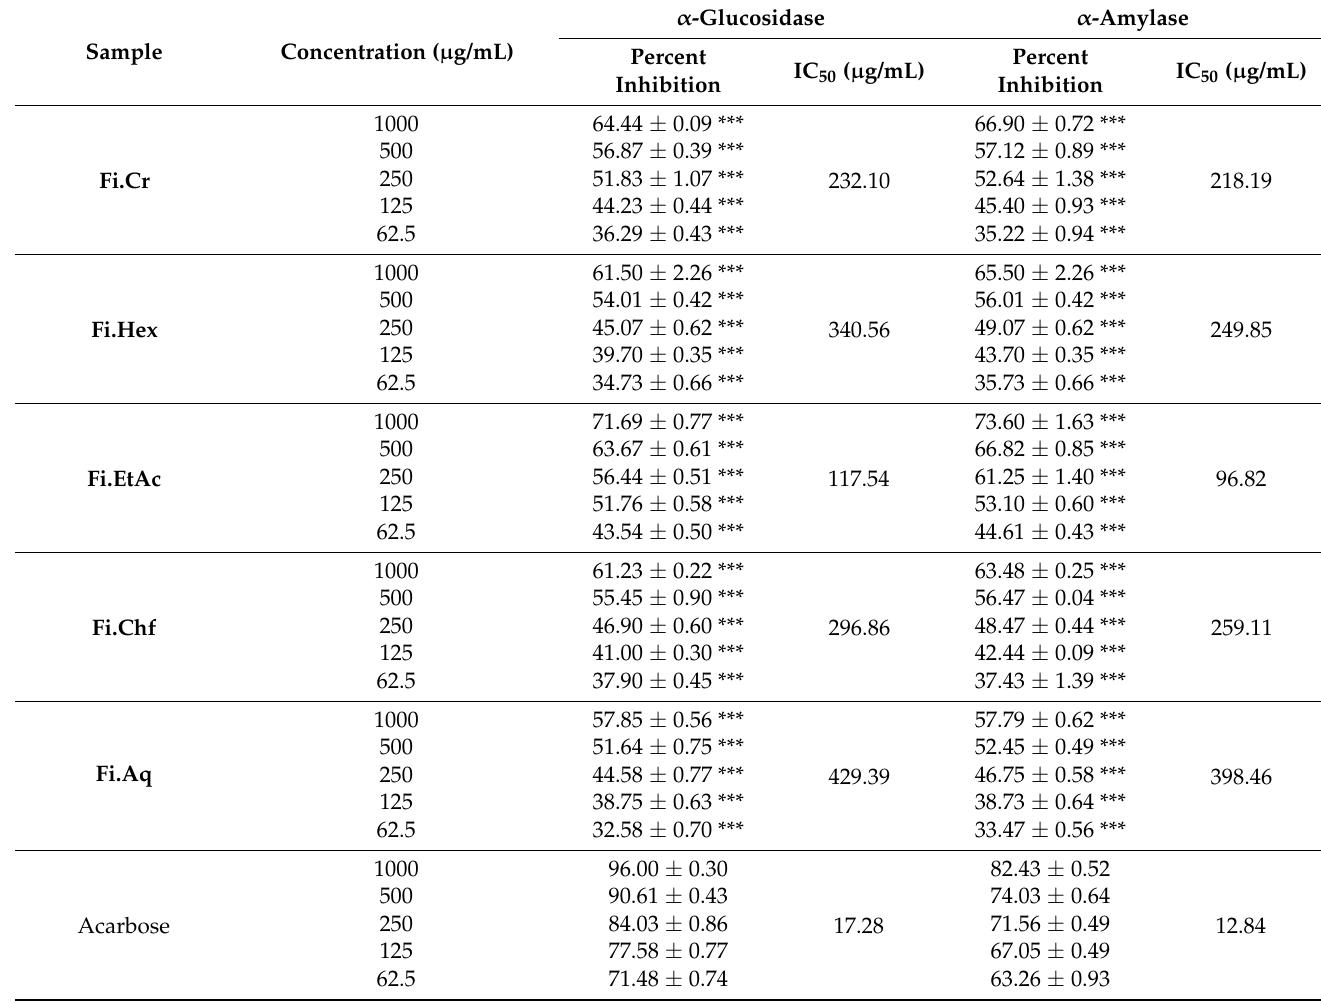
Table 1. α -Glucosidase and α -amylase results of Fragaria indica crude